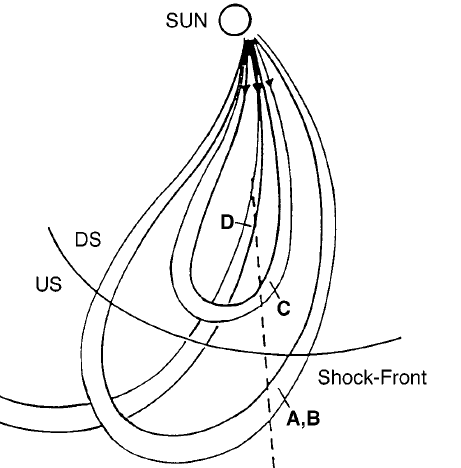
Fig. 4. Sketch of a possible closed (regions A , B , C ) and open (region D ) IMF configuration embedded within the first ICME as evidenced by observations of energetic electron anisotropies. The dashed trace marks Ulysses